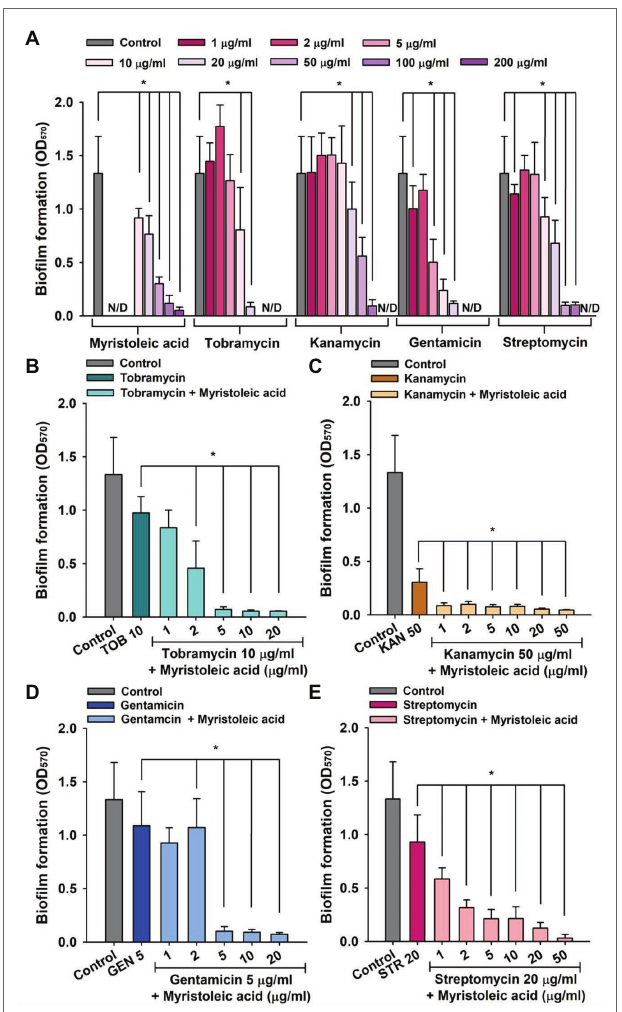
FIGURE 4 | MRSA biofilm inhibition by antibiotics in the presence or absence of fatty acid. Biofilm inhibitions by myristoleic acid, tobramycin, kanamycin, gentamicin, and streptomycin (A) were measured after incubating in 96-well plates for 24 h at 37 ° C under static conditions. Antibiofilm activities of tobramycin (B) , kanamycin (C) , gentamicin (D) , or streptomycin (E) plus myristoleic acid were measured after incubation under identical conditions. Error bars indicate standard deviations. * p < 0.05 vs. untreated controls (A) . * p < 0.05 vs. antibiotic-treated controls (B–E) . TOB; tobramycin, KAN; kanamycin, GEN; gentamicin, STR; streptomycin, Control; untreated control. N/D indicates “Not